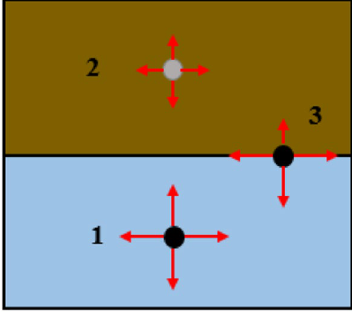
Fig. 1 Attraction forces for two immiscible